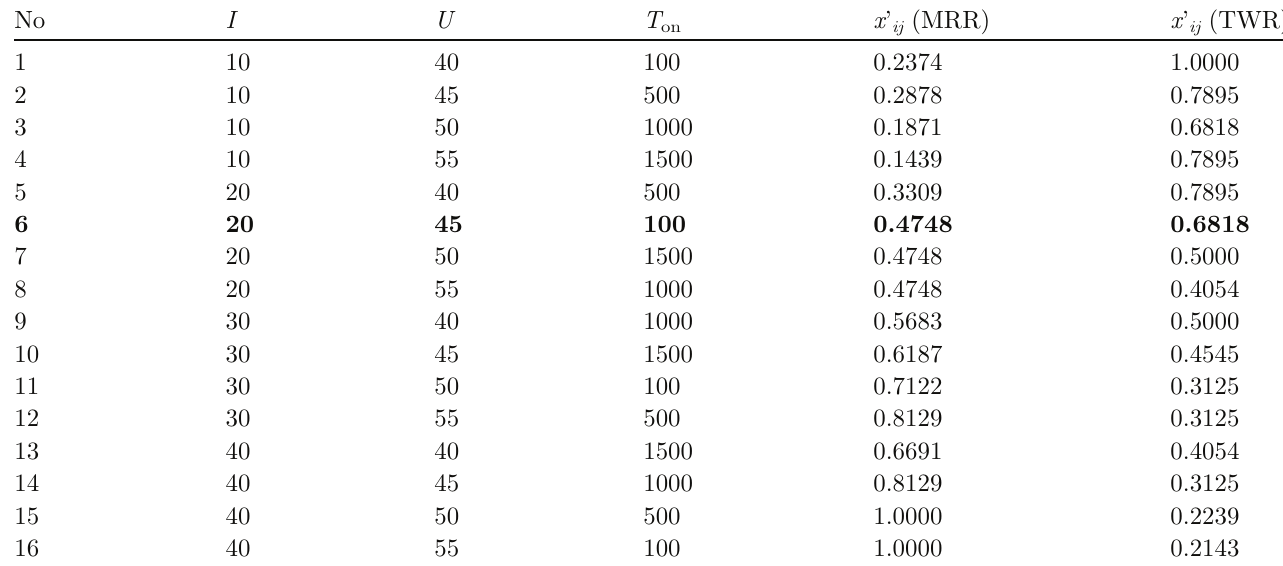
Table 4. Normalization